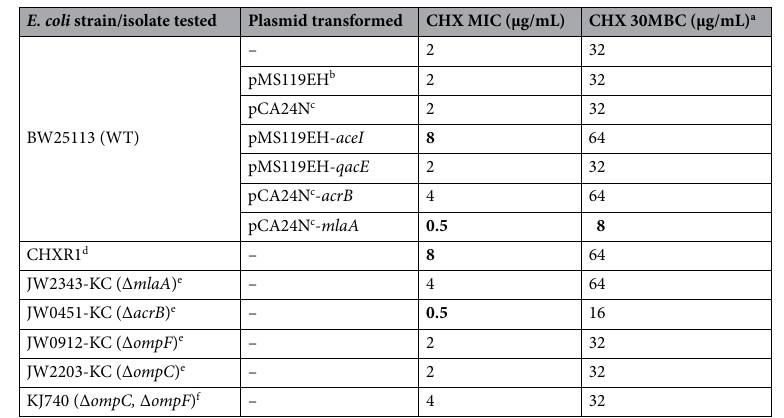
Table 1. A summary of CHX AST E. coli K-12 isolates, mutants and transformants MIC and 30MBC values determined in this study. a 30MBC; 30-min minimal biocide concentration. b pMS119EH; Ampicillin-selective P-tac expression vector as described in 52 . c pCA24N; Chloramphenicol-selective T5/ lac expression vector lacking the green fluorescent protein fusion tag as described in 31 . d CHX-adapted BW25113 isolate 1, resistant to 9.6 µg/mL CHX after 20 sub-cultures 22 . e Single genome deletion strains obtained from BW25113 as part of the Keio collection 30 . f Strain obtained from the Yale Coli Genetic Stock Centre (https:// cgsc. biolo gy. yale. edu/) as KJ740 (AW740 and generated for the study by 34 . It is derived from the parental E. coli K-12 strain AW607 which when AST has the same CHX MIC and 30MBC as WT BW25113. Significant values are given in